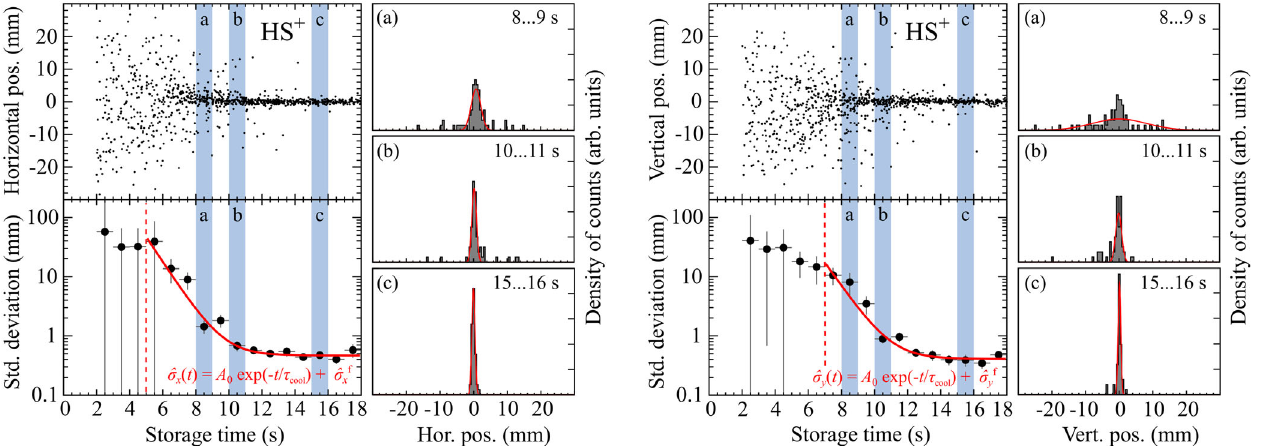
FIG. 4. Transverse electron cooling of HS þ at 2.7 MeV ( 81 keV = nucleon). Although electron cooling started directly at ion injection, data was recorded only for storage times ≥ 2 s. The plots are analogous to the case of 16 O 18 O þ from Fig.